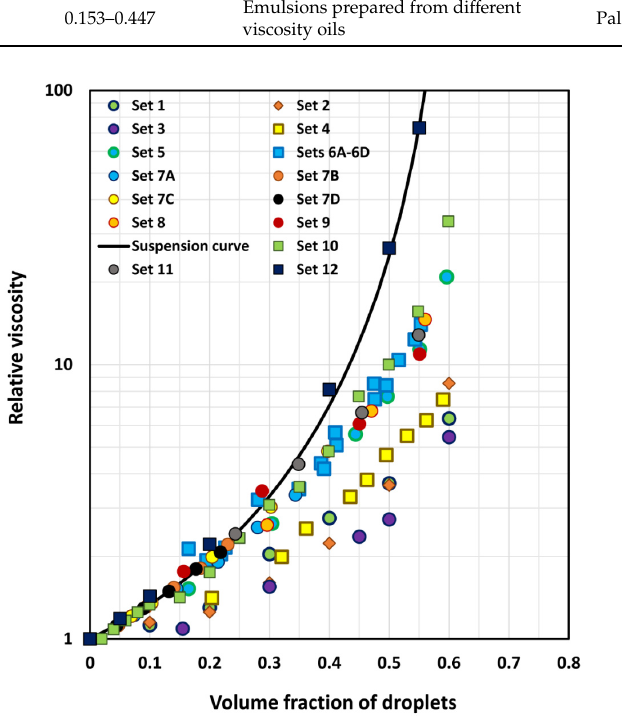
Figure 20. Comparison of experimental viscosity data for emulsions with proposed suspension model (Equation (34) with φ m of 0.637). When the effect of viscosity ratio is taken into account, the agreement between the experimental emulsion viscosity data and model prediction improves markedly. Figure 21 shows comparison between emulsion viscosity data and proposed emulsion model (Equation (44)) that takes into consideration the effect of the viscosity ratio. Clearly the agreement between the model prediction and experimental data has improved markedly as compared with the suspension viscosity model shown in Figure 20. The maximum packing volume fraction (cid:2038) (cid:3040) is taken as 0.637 in the model. Although the proposed emulsion model (Equation (44)) with (cid:2038) (cid:3040) of 0.637 describes the experimental data reasonably well, there is a significant scatter of data around the model prediction. Interestingly, the proposed model, Equation (44), describes the experimental viscosity data adequately with (cid:2038) (cid:3040)(cid:3008)(cid:3039)(cid:3028)(cid:3046)(cid:3046) ≤ (cid:2038) (cid:3040) ≤ (cid:2038) (cid:3040)(cid:3009)(cid:3004)(cid:3017) , where (cid:2038) (cid:3040)(cid:3008)(cid:3039)(cid:3028)(cid:3046)(cid:3046) is the glass transition concentration of droplets where the emulsion becomes glassy and (cid:2038) (cid:3040)(cid:3009)(cid:3004)(cid:3017) is the hexagonal close packing concentration of droplets. Note that (cid:2038) (cid:3040)(cid:3008)(cid:3039)(cid:3028)(cid:3046)(cid:3046) = 0.58 and (cid:2038) (cid:3040)(cid:3009)(cid:3004)(cid:3017) = 0.7404 for uniform spherical droplets. Figure 22 show the bounds generated from the model, Equation (44), using 0.58 ≤ (cid:2038) (cid:3040) ≤ 0.7404 . As can be seen, most of the experimental data fall within the bounds: the upper bound with (cid:2038) (cid:3040) = (cid:2038) (cid:3040)(cid:3008)(cid:3039)(cid:3028)(cid:3046)(cid:3046) = 0.58 and the lower bound with (cid:2038) (cid:3040) = (cid:2038) (cid:3040)(cid:3009)(cid:3004)(cid:3017) = 0.7404. The variation or spread in experimental relative viscosity data at a given concentration of droplets is largely due to different packing microstructure, and hence different (cid:2038) (cid:3040) values, of different emulsion systems. Interestingly, the experimental viscosity data for emulsions can be collapsed on to a single curve by slight tweaking of (cid:2038) (cid:3040) values. Figure 23 shows the plot where all the experimental viscosity data collapse on to a single master curve. The data are plotted as (cid:2015) (cid:3045) versus (cid:2038) (cid:3032)(cid:3033)(cid:3033) where (cid:2038) (cid:3032)(cid:3033)(cid:3033) is defined in Equation (31). Table 5 summarizes the (cid:2038) (cid:3040)